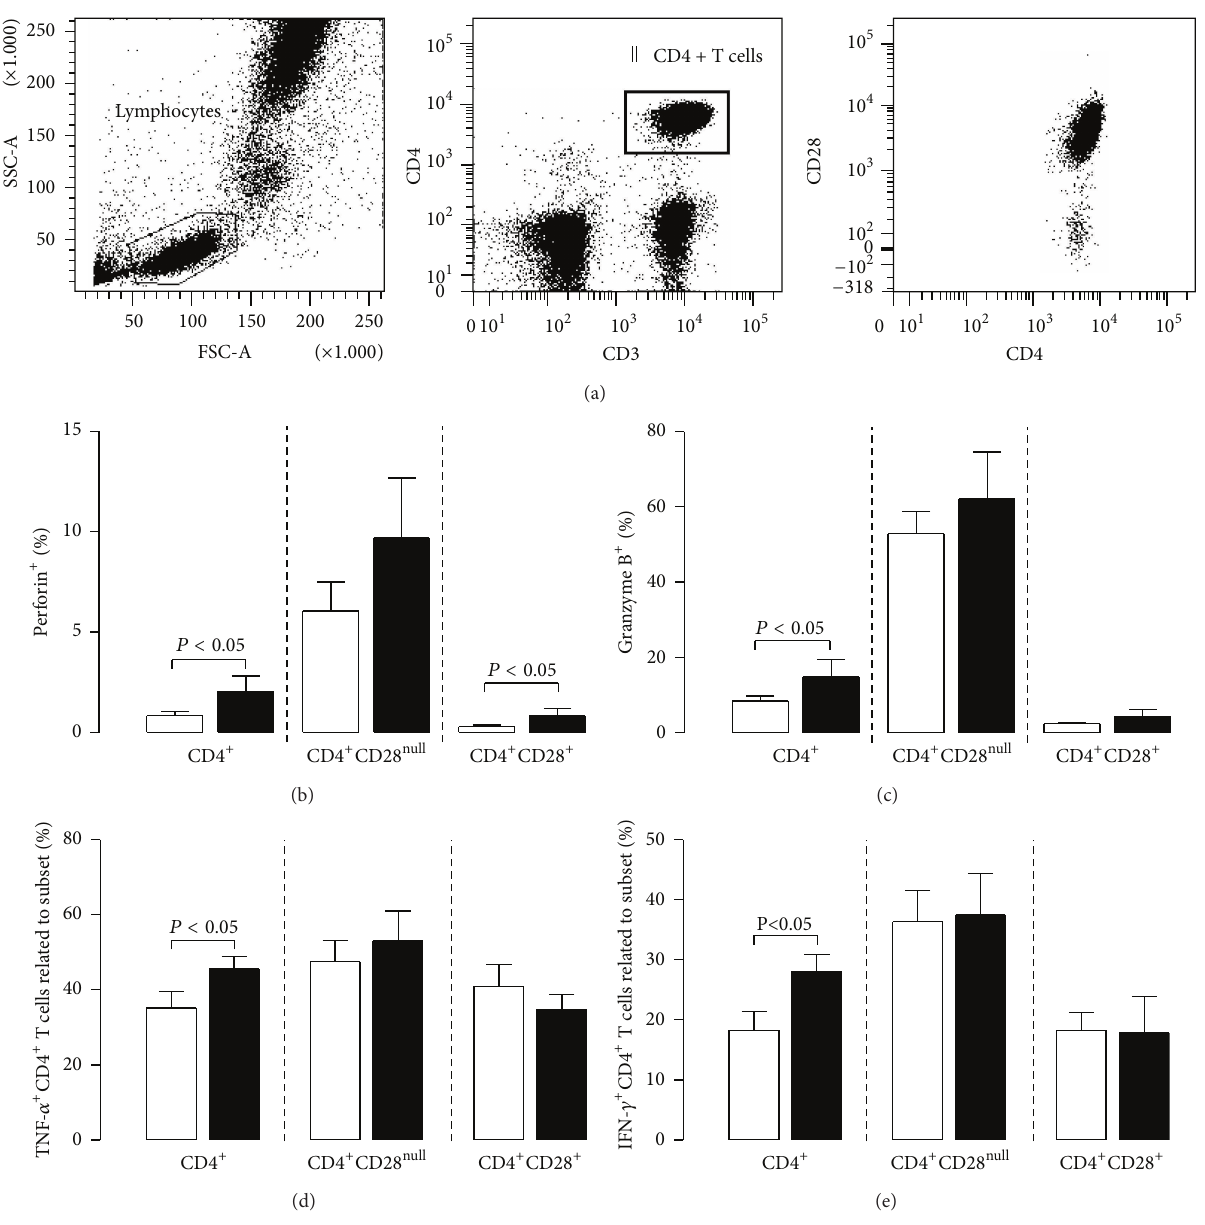
Figure 3: Expression of cytotoxic molecules and proinflammatory cytokines in the total population of circulating CD4 + T cells and the CD28 + and CD28null subsets within ESRD patients before kidney transplantation. In (a), a typical flow cytometric example is depicted with respect to the dissection of CD4 + T cells into those expressing CD28 (CD4 + CD28 + ) and those lacking CD28 (CD4 + CD28null). Next, we determined the cytotoxic potential by analyzing percentages of perforin + (b) and Granzyme B + (c) CD4 + T cells as well as those expressing or lacking CD28 in 11 ESRD patients known with atherosclerotic disease (CVDpos, closed bars) before transplantation and compared that to 27 age- and sex-matched ESRD patients, not known with preexisting atherosclerotic disease (CVDneg, open bars). In addition, PBMC of 8 CVDpos ESRD patients (closed bars) and 12 age- and sex-matched CVDneg patients (open bars) were stimulated with PMA and ionomycin in order to be able to analyze percentages of the proinflammatory cytokines TNF- 𝛼 + (d) as well as IFN- 𝛾 + (e) within CD4 + and CD4 + CD28 + and CD4 + CD28null T